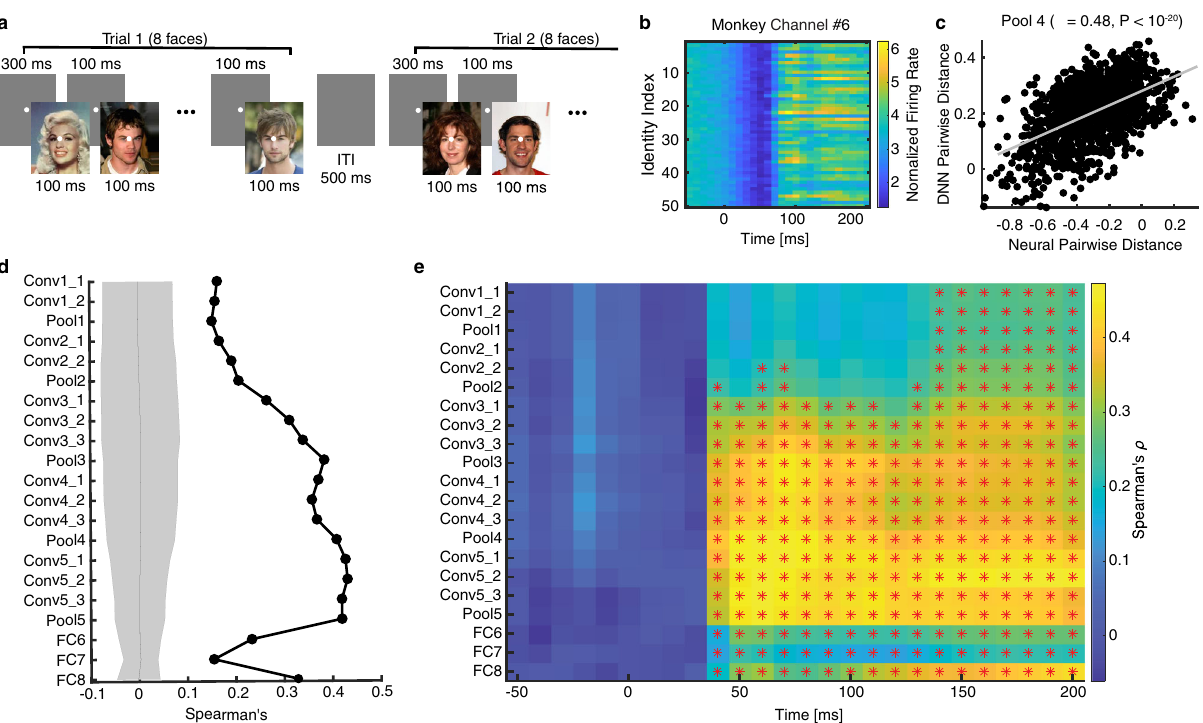
Fig. 5 Comparison between the deep neural network (DNN) units and (real) monkey inferotemporal (IT) cortical neurons. a Task used to acquire neural responses from a monkey. In each trial, eight faces were presented for 100 ms each, followed by a fi xed interstimulus interval (ISI) of 100 ms. There was a central fi xation point of 300 ms at the beginning of each trial and there was an intertrial interval (ITI) of at least 500 ms following each trial. The central fi xation point persisted through the trial. b , c An example multiunit-activity (MUA) channel showing a signi fi cant correspondence with the DNN feature space. b MUA to 50 identities, shown in 10 ms time bins. Time 0 denotes the stimulus onset. Firing rate was normalized to the average of the gray images (i.e., control stimuli). c Correlation between MUA pairwise distance and DNN layer Pool4 feature pairwise distance (see “ Methods “ ). Each dot represents a face pair, and the gray line denotes the linear fi t. d Correlation between pairwise distance in the monkey inferotemporal (IT) neuronal face space and pairwise distance in the DNN face space. Here, we used the mean fi ring rate in a time window 70 ms to 180 ms after stimulus onset as the response to each face, and we averaged the responses to ten faces for each face identity. We calculated the correlation using all identities. Solid circles represent a signi fi cant correlation (permutation test: P < 0.05, Bonferroni correction across layers). The shaded area denotes ±SD across permutation runs. e Temporal dynamics of correlation of pairwise distance between monkey neurons and DNN units (bin size = 40 ms, step size = 10 ms). Color coding indicates the magnitude of Spearman ’ s correlation. Asterisks (*) indicate a signi fi cant correlation in that bin (permutation test: P < 0.05, Bonferroni correction across time bins for each